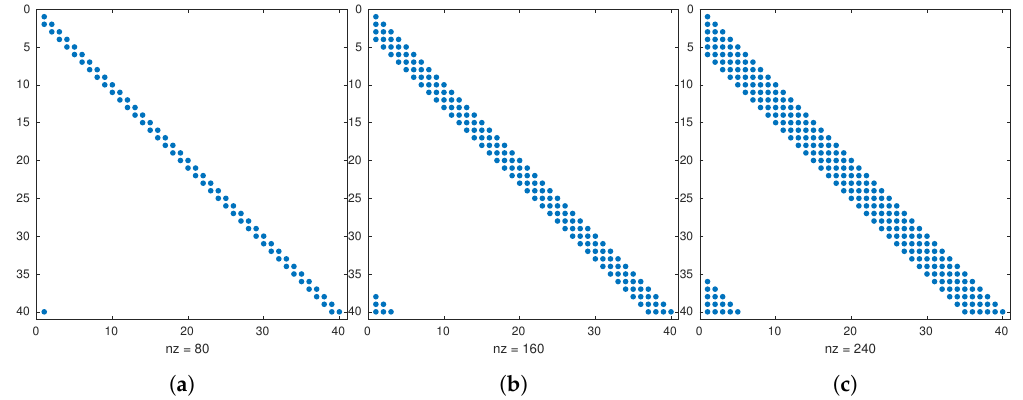
Figure 1. Structure of the Cholesky factor (cid:98) V k as a function of the localization radius δ . ( a ) δ = 1; ( b ) δ = 3; ( c ) δ =